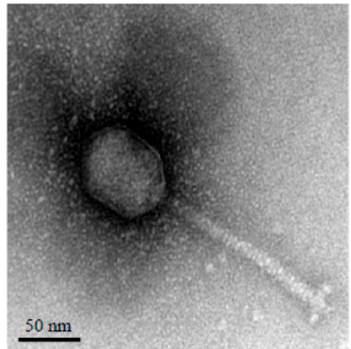
Figure 1. Transmission electron micrograph of the vB_StuS_MMDA13 phage negatively stained with uranyl acetate. The bar indicates 50 nm.